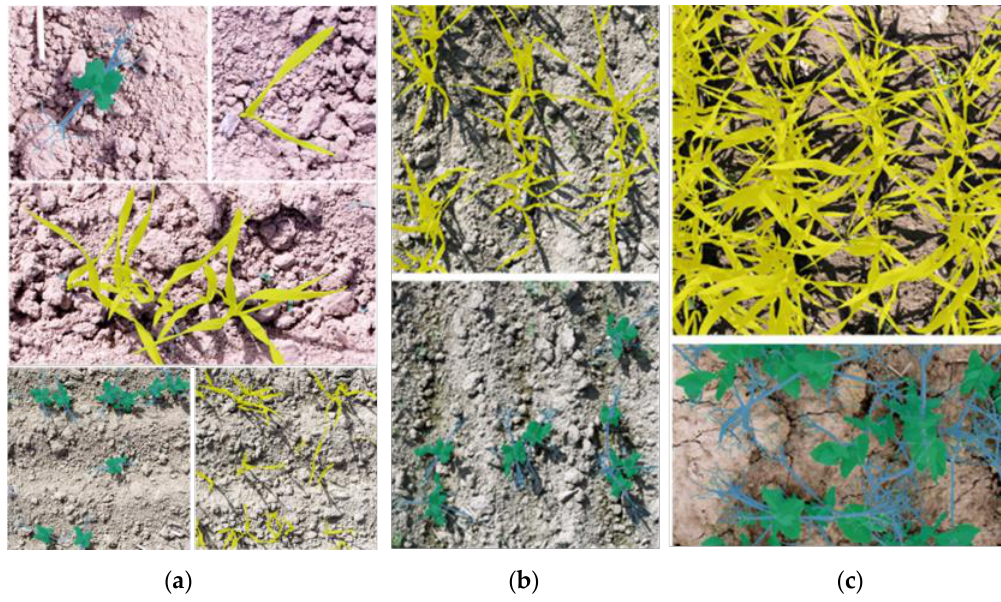
Figure 3. Examples of labeled images for training of the three networks: ( a ) low cover (LC), ( b ) intermediate cover (IC), and ( c ) high cover (HC). Three classes were labeled: pea leaves (green), pea tendrils (blue), and oat plants (yellow).